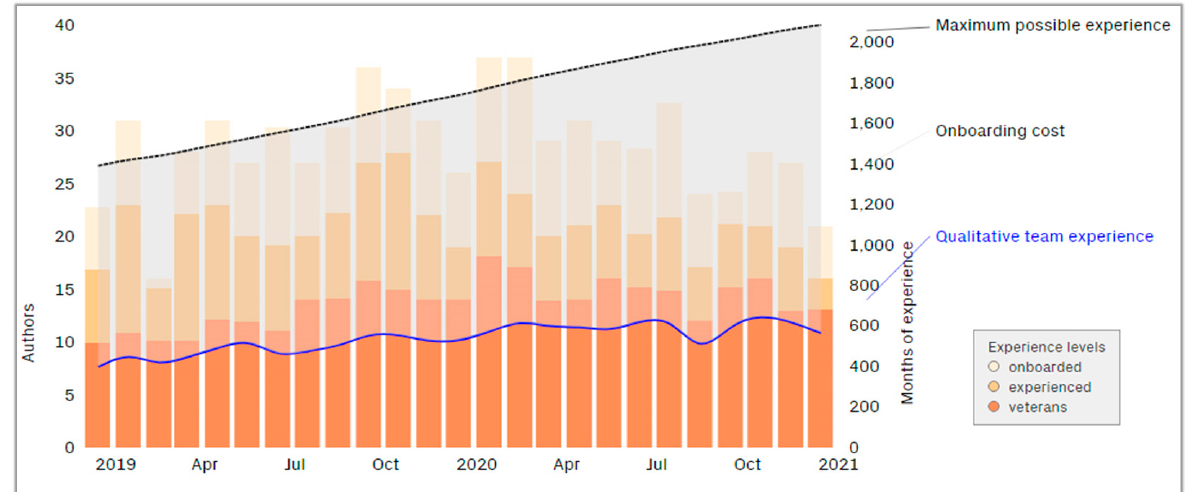
Figure 2. CodeScene representation of RIOT team composition.